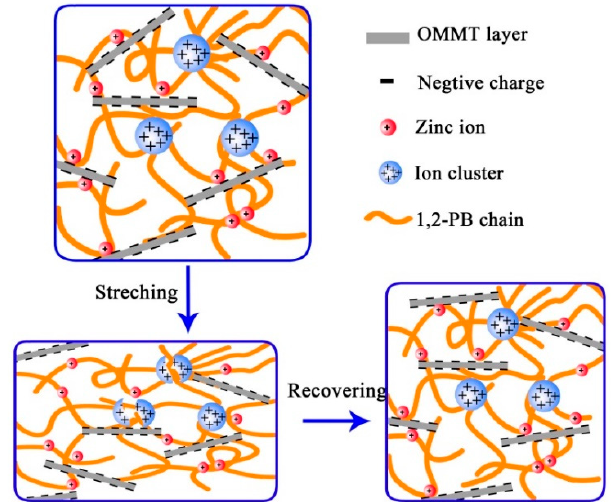
Scheme 2. Proposed mechanism of the rupture and reconstruction of sacrificial bonds in the multi-network system of 1,2-PB.